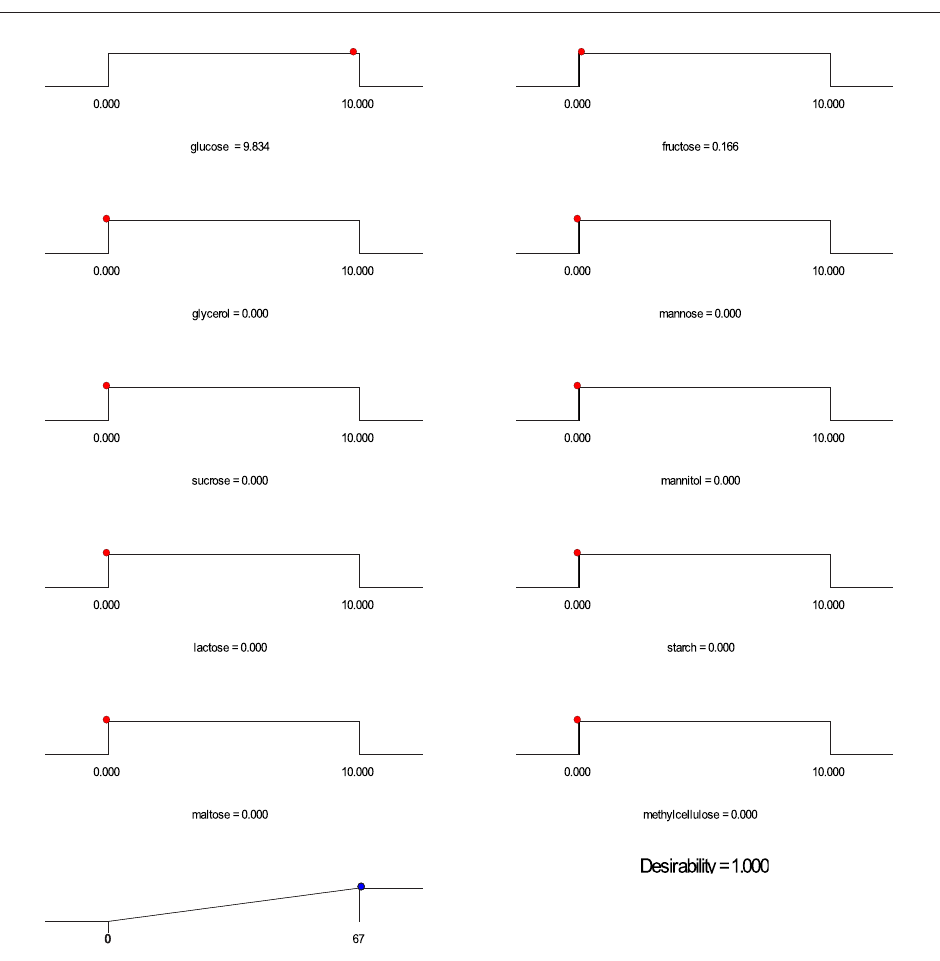
Fig. 4. Ramp chart for statistically optimize carbone source for actinorhodin production by Streptomyces coelicolor